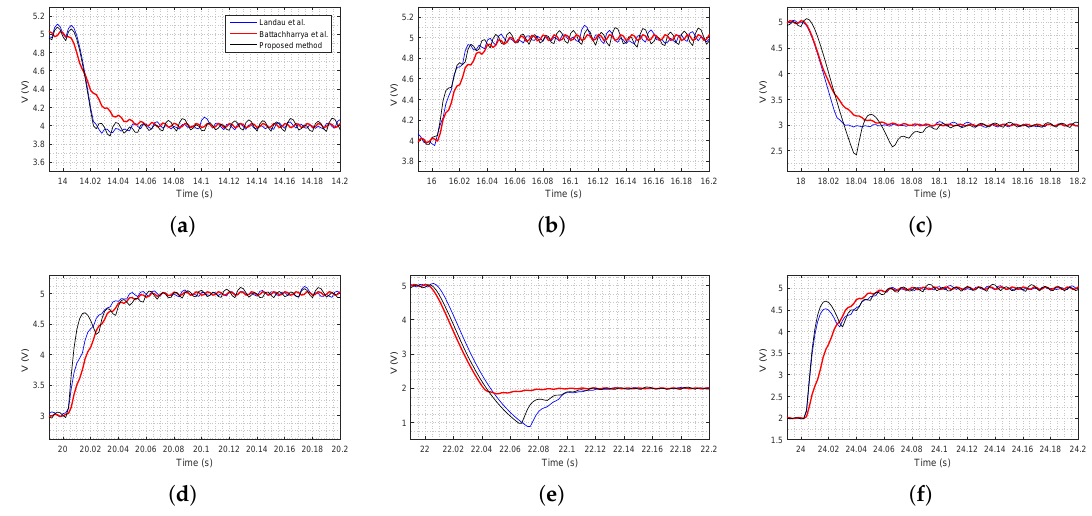
Figure 11. Simulation results of the negative voltage setpoint variation. ( a ) V ref = 4.0 V; ( b ) V ref = 5.0 V; ( c ) V ref = 3.0 V; ( d ) V ref = 5.0 V; ( e ) V ref = 2.0 V; ( f ) V ref = 5.0 V.